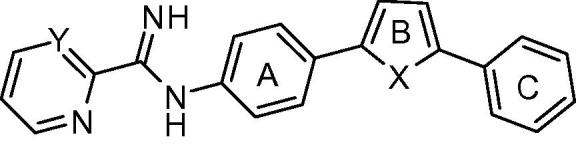
Mono-AIA scaffold.